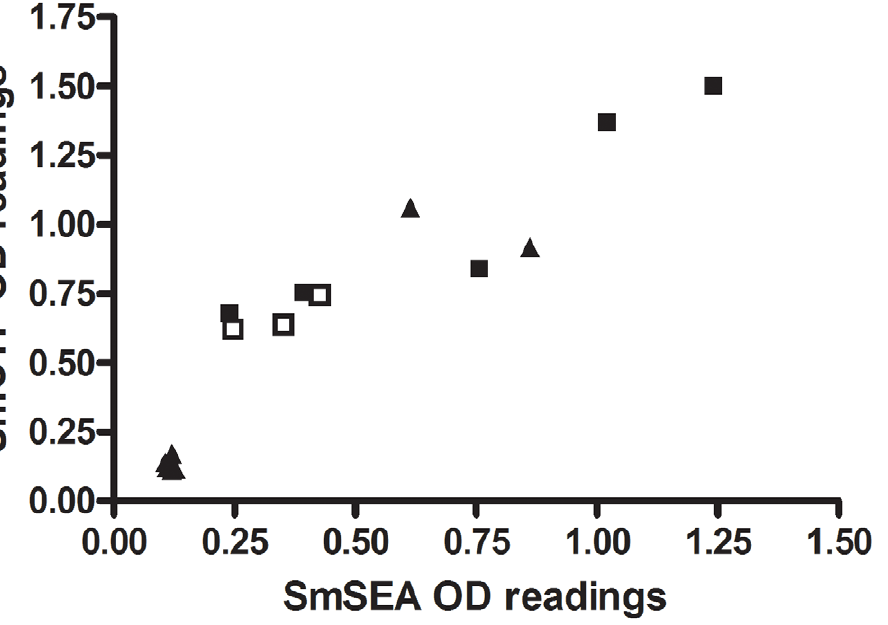
Figure 3. SPDRL: correlation between S.mansoni cercarial transformation fluid (SmCTF) and soluble egg antigen (SmSEA) in ELISA. Results for sera from 8 subjects previously shown parasitologically to be infected with S. haematobium and 8 subjects suspected to be infected with S. haematobium . m =2 positive and 6 negative sera from patients that had visited Lake Malawi; % =patients with S. haematobium eggs in urine; & =control positive sera from patients known to be S. haematobium -infected.